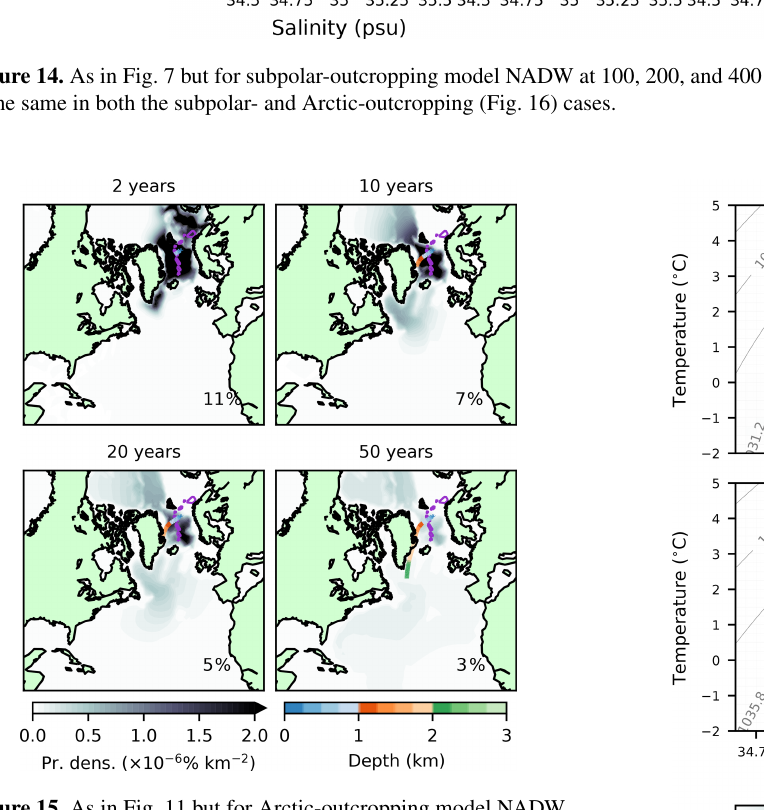
Figure 15. As in Fig. 11 but for Arctic-outcropping model NADW.